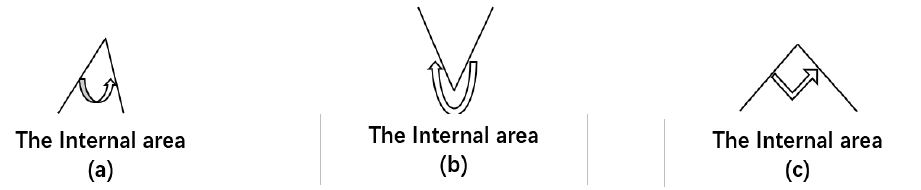
Figure 4. Diagrams of raised and sunken areas: ( a ) The angle is too small; ( b ) the angle is too large; and ( c ) the angle is 90°.